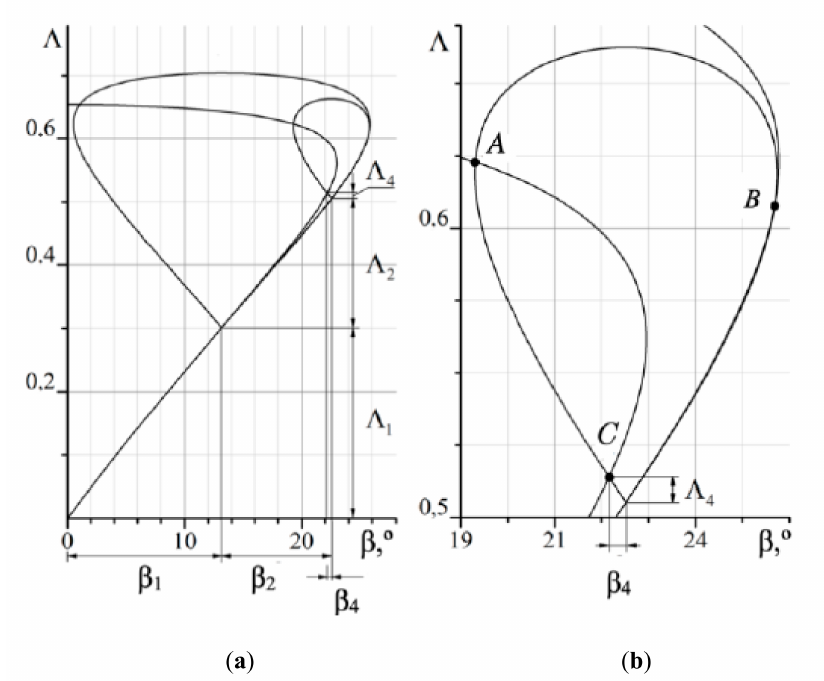
Figure 4. Analysis of the problem of analysis of overtaking shocks on the shock polar plane. ( a ) shows the determination of intensity ( Λ 4 = lnJ4) and the angle of flow ( β 4) of the reflected discontinuity with the interference of overtaking shock waves, where β 1 and β 2 are the angles of flow at the wedges and M is the freestream Mach number. ( b ) shows additional points of intersection of the third shock polar that correspond to the re-flected discontinuity R, with the first polar A and the second polar B, as well as point C, which corresponds to the solution with the reflected discontinuity (the shock